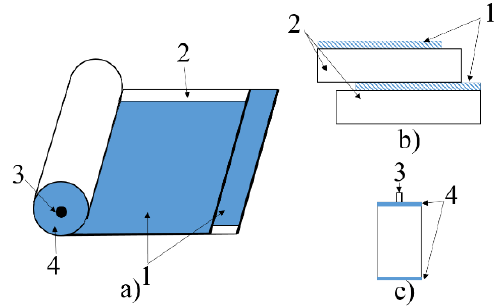
Figure 3. Structure of a capacitor element of an MFC (( a ) expanded view; ( b ) sectional view; ( c ) front view of the MFC). 1—metallic coating, 2—polymer film, 3—insulated mandrel, 4—metal spraying layer.